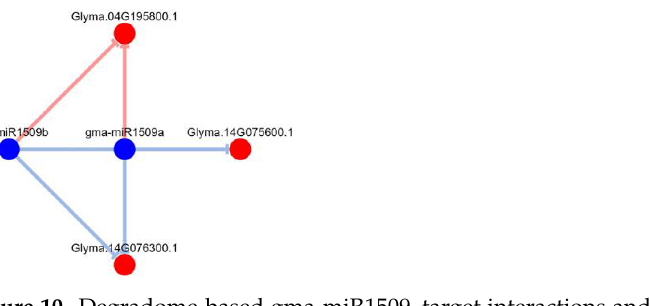
Figure 10. Degradome-based gma-miR1509–target interactions and network. Note: we used DPMIND software (http://cbi.njau.edu.cn/DPMIND/network.php?race_id=3847, 1 January 2022) to obtain the network. Note: blue circles indicate miRNA, red circles indicate targets, red lines indicate strong evidence, blue lines indicate weak evidence.